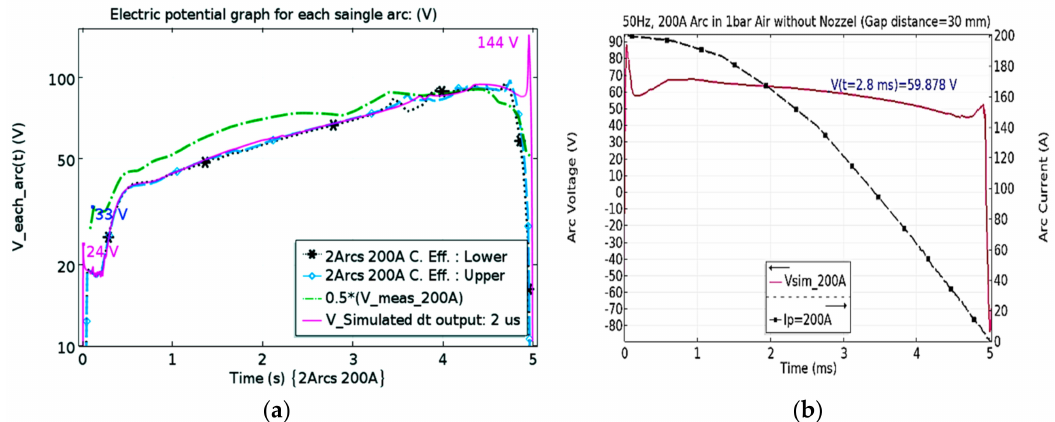
Figure 15. Measured and simulated arc voltages for 200 A peak arcs in ( a ) Prototype FS with u c = 9 m / s and ( b ) Fixed contact distance of 30 mm initiated by exploding wire at the same current cycle.